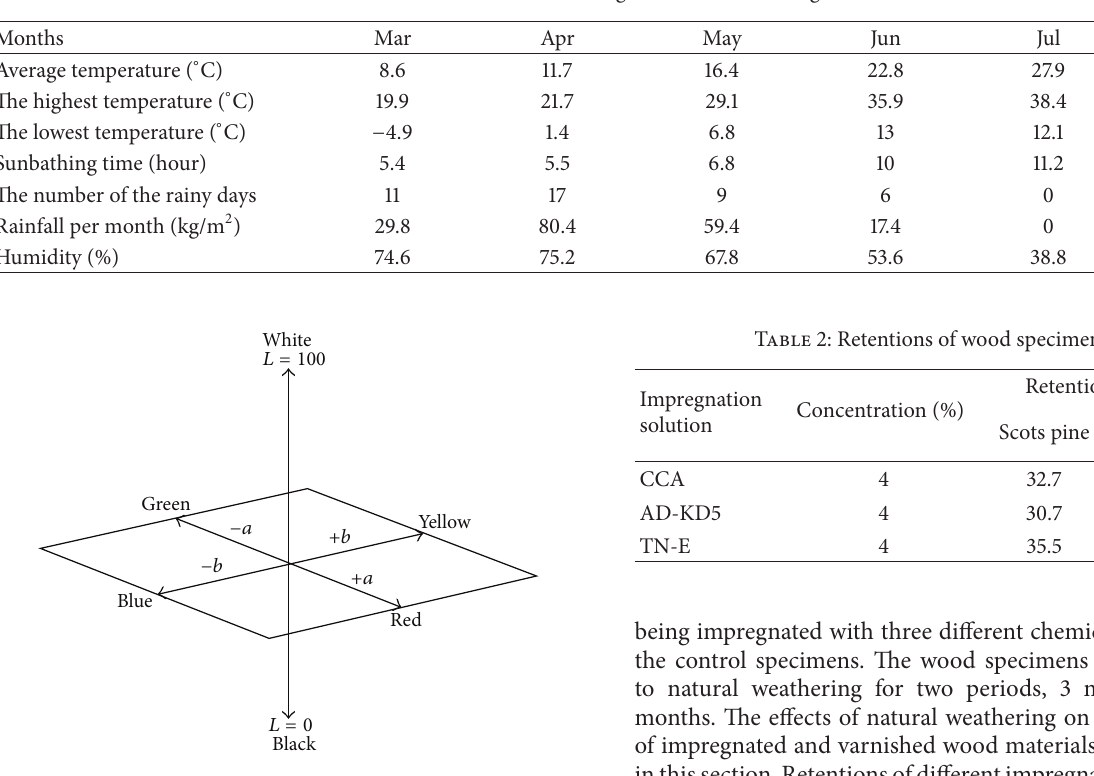
Figure 1: The CIE 𝐿 ∗ 𝑎 ∗ 𝑏 ∗ color space.